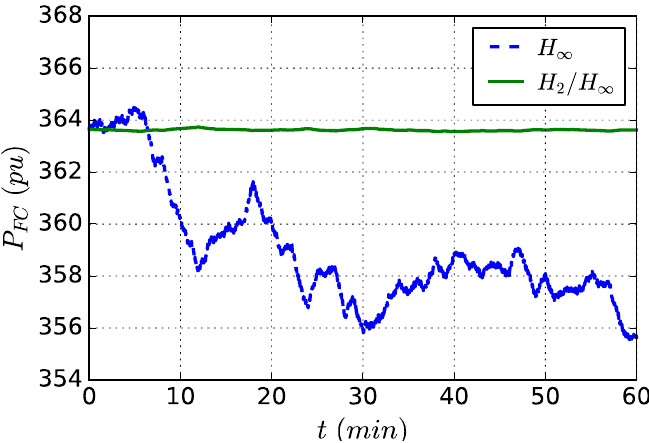
Energies 2019 , 12 , 340 Figure 4. Power output curves of fuel cells (FC) under mixed 𝐻 (cid:2870) /𝐻 (cid:2998) control and 𝐻 (cid:2998) control methods. Figure 4. Power output curves of fuel cells (FC) under mixed H